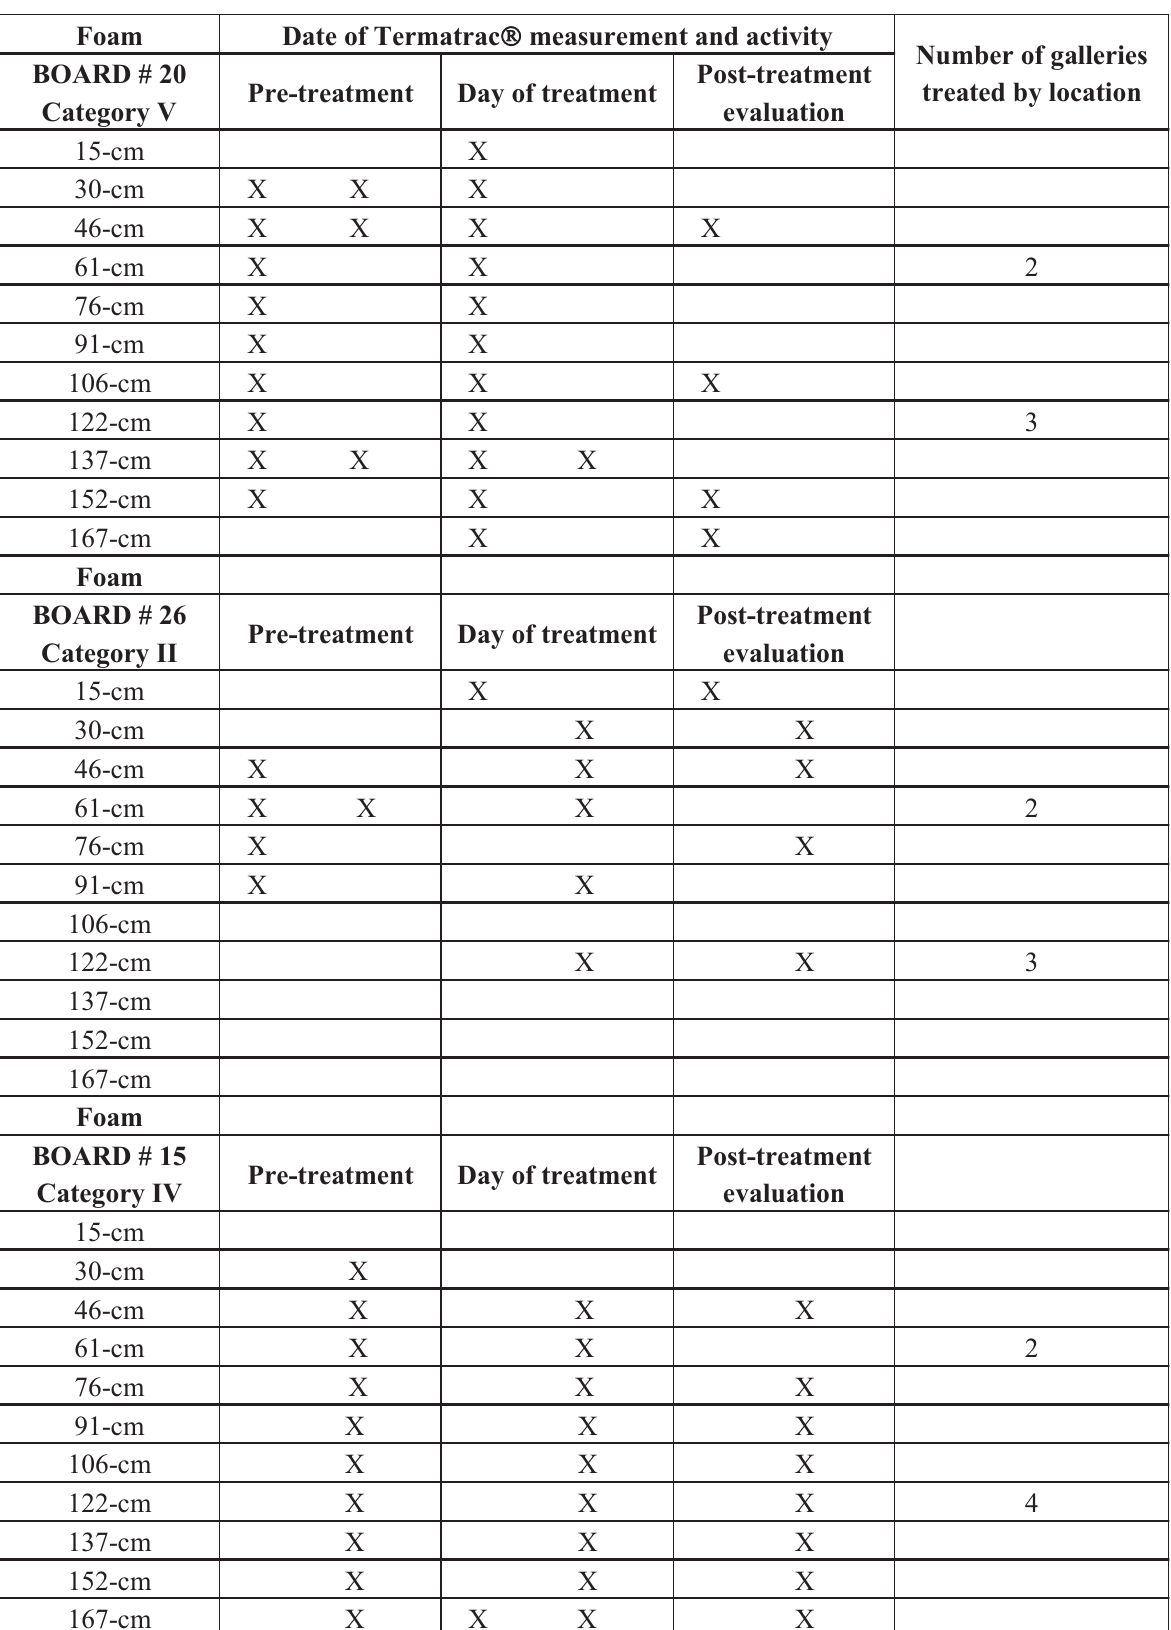
Date of Termatrac (cid:2)(cid:2) measurement and